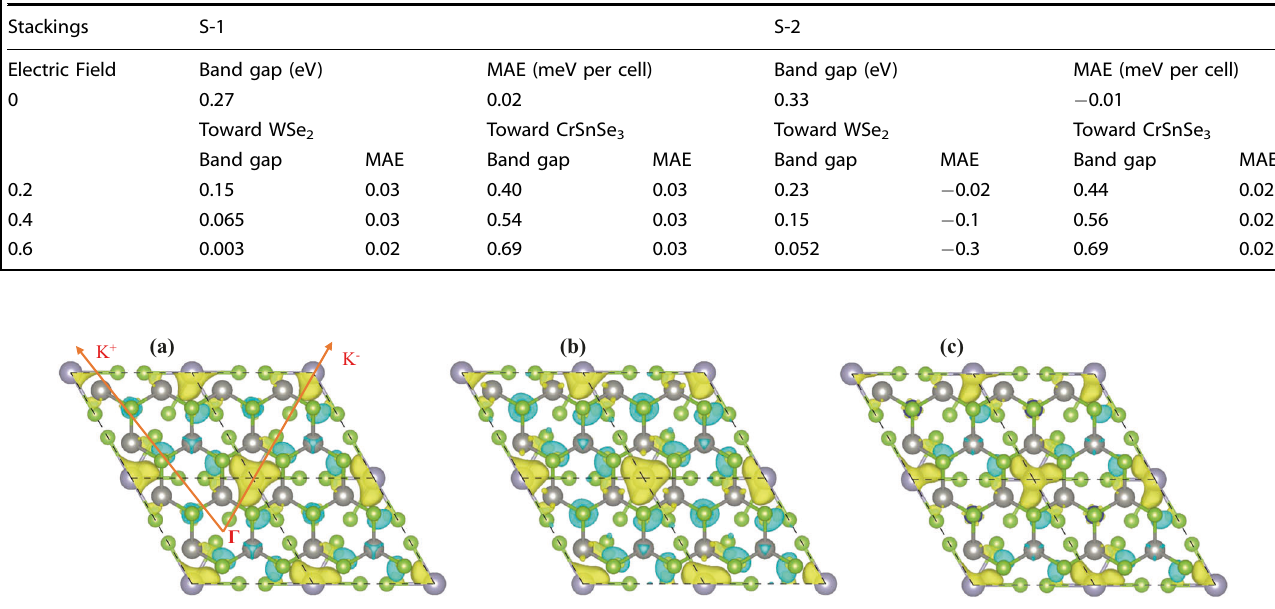
Fig. 6 Charge density difference. Top view of the charge density difference in S-2 stacking at a zero b − 0.4 VÅ − 1 , and c + 0.4 VÅ − 1 . The yellow color represents the charge accumulation while the cyan color is for the charge temperature of the 2D CrSnSe 3 layer was 61 K, and we obtained a magnetic anisotropy of 0.02 meV per cell while the S-2 showed a perpendicular magnetic anisotropy of 0.03 meV per cell. The small in-plane anisotropy of − 0.01 meV per cell. The Curie WSe 2 /CrSnSe 3 heterostructure had an FM ground state, and we found indirect band gaps of 270 and 330 meV in S-1 and S-2 stacked systems. The S-1 structure had a weak out-of-plane